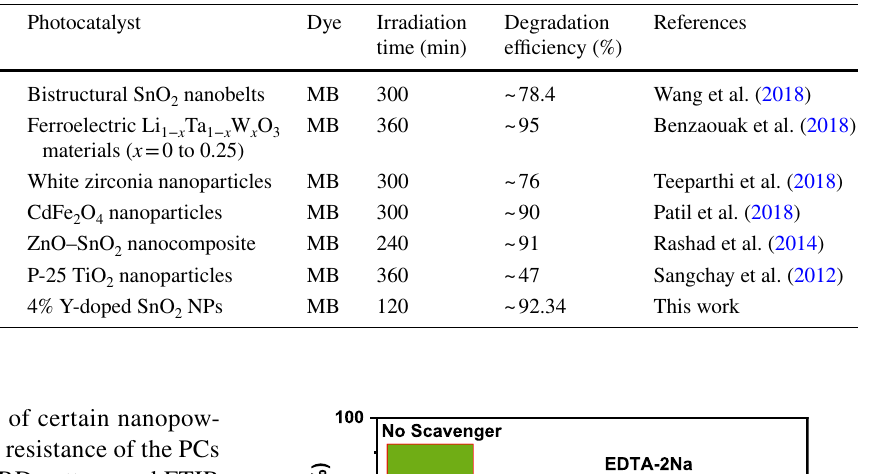
Table 1 Comparison of visible light generated MB degradation rate (%) over of previously reported nanomaterials